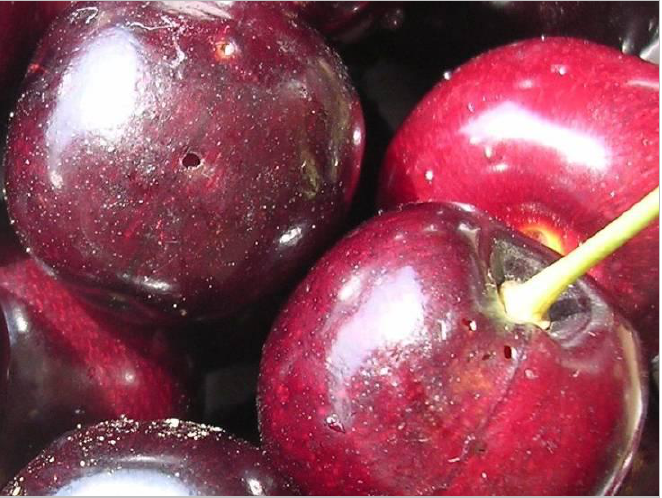
Figure 4. Damaged cherries with exit holes of larvae.